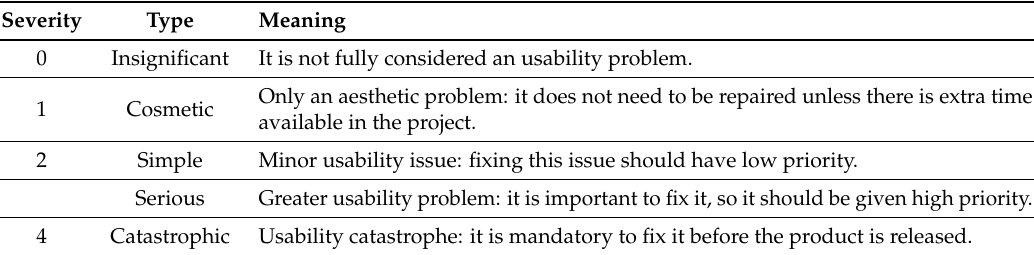
Table 4. Severity scale assigned in the heuristic evaluation.